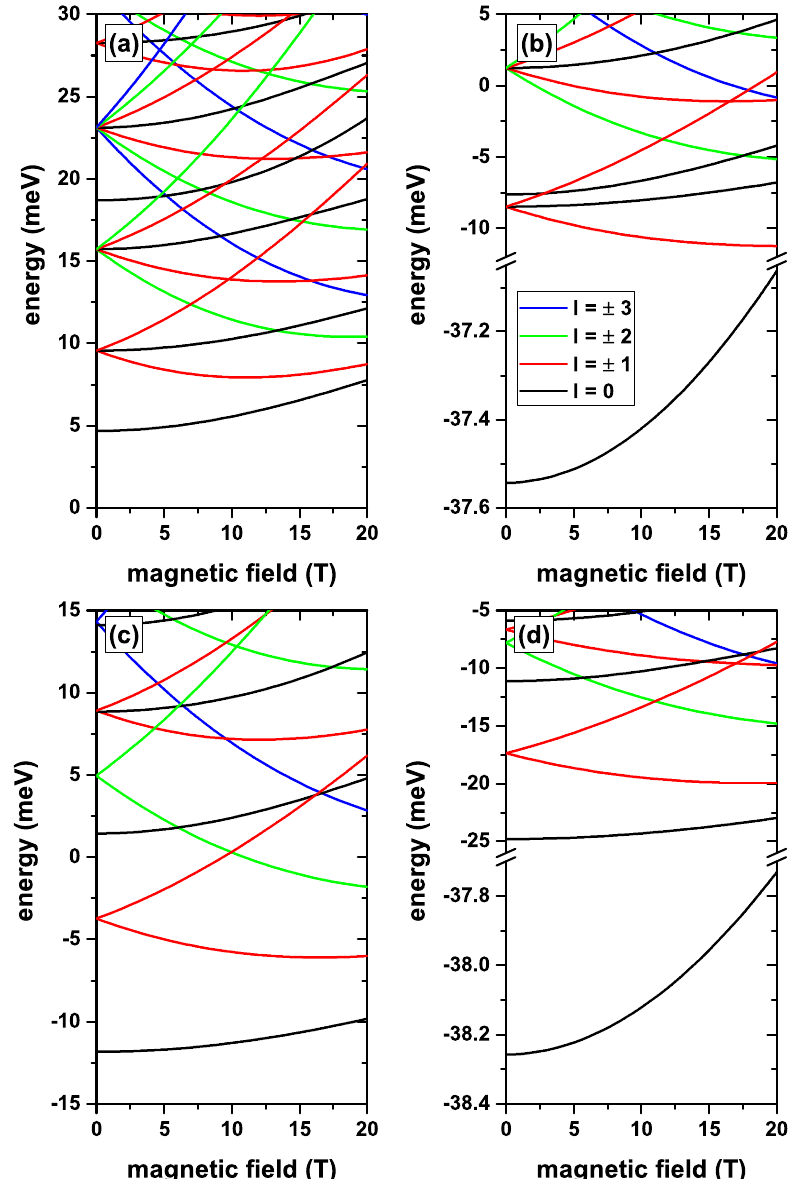
Figure 5. (color online) The lowest confined electron states in a CdS/ZnS spherical QD as functions of the MF. Results are without ( a , c ) and with ( b , d ) on-center donor impurity, with R 1 = 20nm and R 2 = 30nm, for several values of the l -quantum number. Calculations in ( a , b ) are for zero EF, whereas in ( c , d ) the results are for F = − 20kV/cm, z -directed